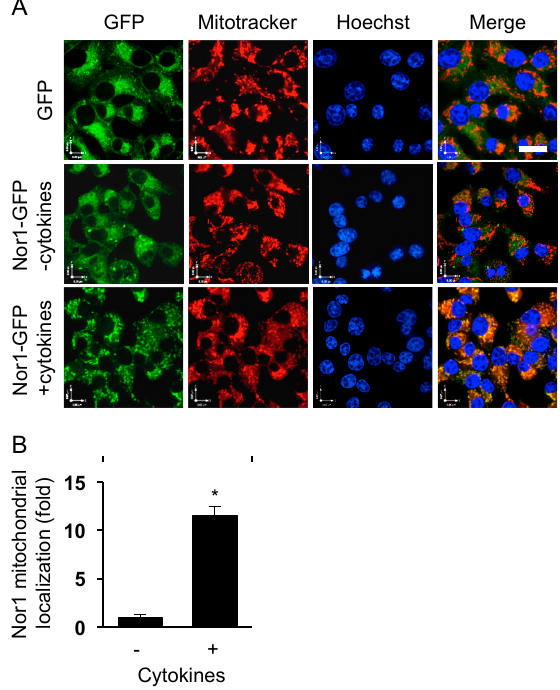
Figure 1. Nor1 translocates to the mitochondria in response to cytokines in INS832/13 cells. ( A ) Images show representative INS832/13 cells transfected with either control GFP or Nor1-GFP and subsequently incubated in the presence or in the absence of cytokines (10 ng/mL IL-1 β and 10 ng/mL IFN γ ) for 1 h. Mitochondria were stained in red (Mitotracker) and nuclei in blue (Hoechst). ( B ) Graph shows the quantification of Nor1-GFP localization at the mitochondria as determined by the overlap of the green and red signals. Scale bar = 20 µ m. Results are mean ± SEM of three independent experiments, * p < 0.05 versus control